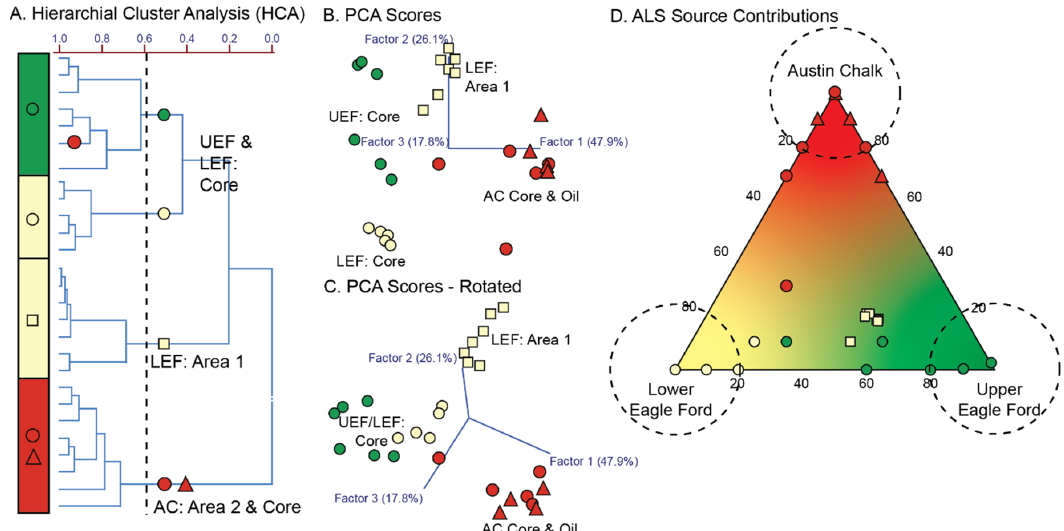
Figure 13. Statistical diagrams for all of the core extracts and a sub-set of the produced oils, specifically the Austin Chalk oils from Area 2 and all of the oils from Area 1, the production area in closest proximity to the pilot core. Color and symbol coding is identical to that in Figures 11 and 12. ( A ) Hierarchical Cluster Analysis (HCA) Dendrogram showing how the oil and extract samples group into tribes geochemically. As with the previous figure the Austin Chalk oil and core samples overlap and, while the Area 1 Lower Eagle Ford oils are closer in similarity to the Eagle Ford core than the Austin Chalk, there is still a distinct geochemical o ff set, also evident in the PCA plots. ( B ) Principal Component Analysis (PCA) scores plots showing the distribution of all of the samples. ( C ) Rotated Principal Component Analysis (PCA) score plot. ( D ) Alternating Least Squares (ALS) source contribution ternary diagram. Each end-point is a geochemically defined end-member (via the ALS algorithm), the dashed circles represent the likely uncertainly cloud and all of the other core and oil samples have been predicted against these end-members. As is evident from the HCA and PCA plots, the produced oils, with the exception of the Austin Chalk fluids, do not show a strong correlation with one